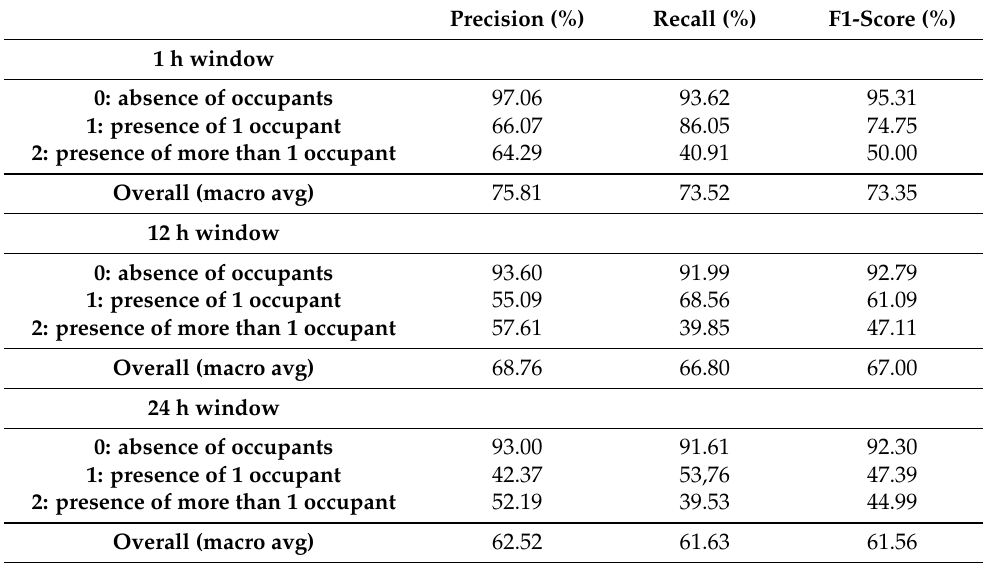
Table 4. Multi-level prediction